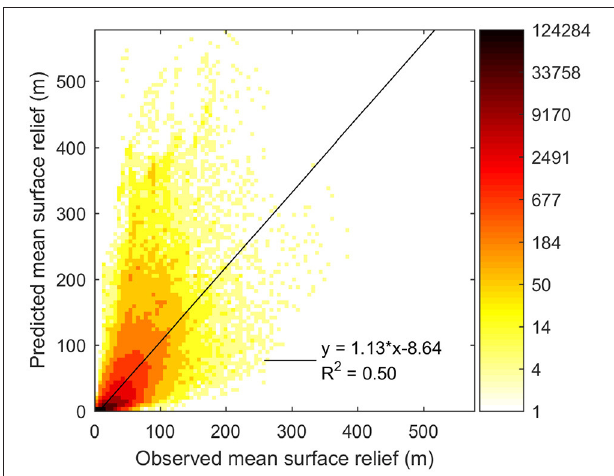
FIGURE 5 | Predicted mean surface relief against observed mean surface relief calculated along our flowlines (before interpolation), on a data density plot. The color bar indicates the number of data points per